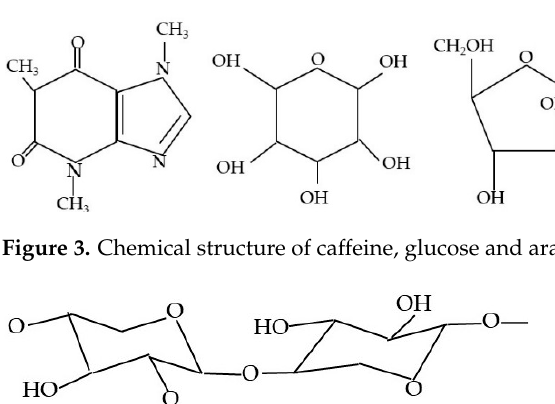
Figure 2. Levels of caffeine (in % of 1 g/L) bonding to hemicellulose (glucogalactomannan—GGM), its sugar precursors (glucose = G, arabinose = A) and the sugar polymers (xylan = X, mannan = M, galactomannan = GM) and the polysaccharides ratio corresponding to hemicelluloses of spruce, pine or beech wood.